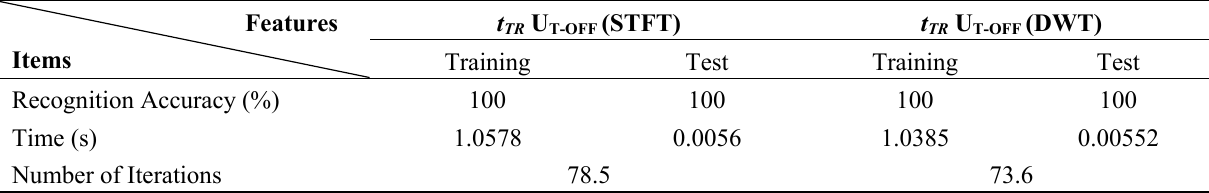
Table 5. The Results of Load Identification in Case Study